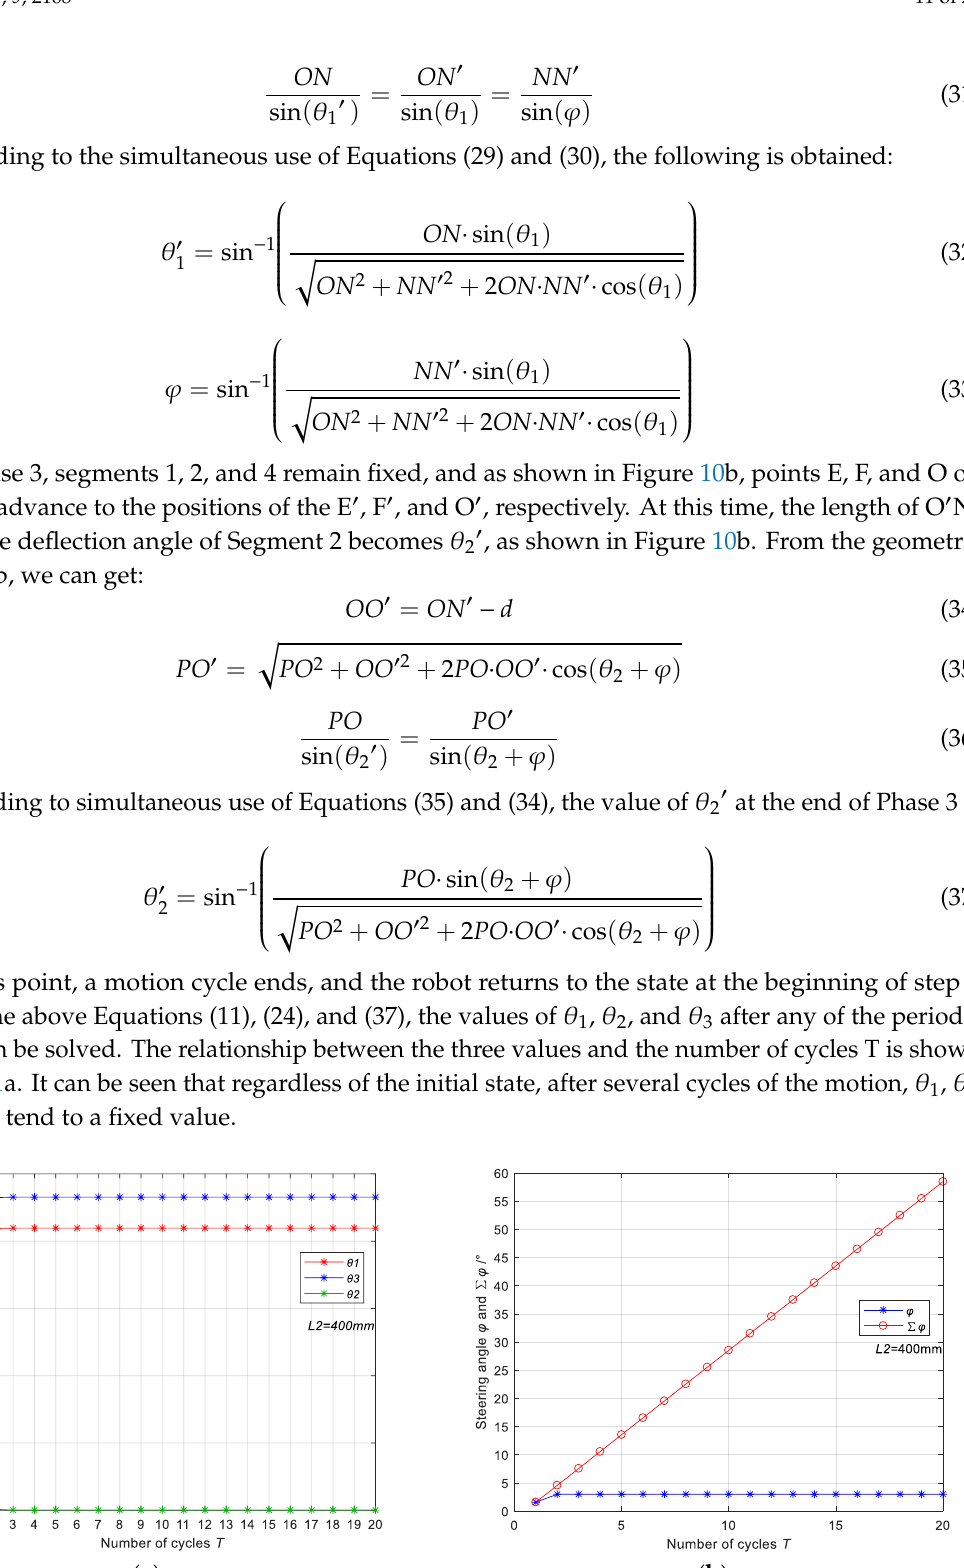
(cid:80) ϕ changing